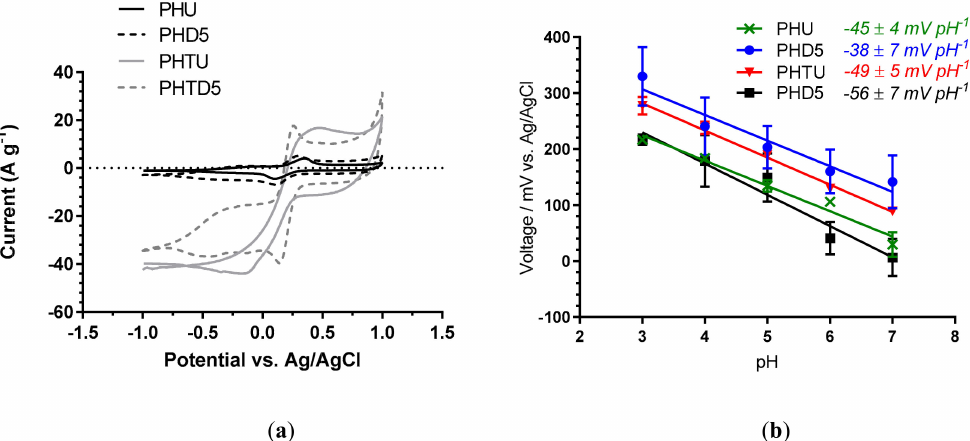
Figure 6. ( a ) Cyclic voltammograms of fibers PHU, PHD5, PHTU and PHTD5. Measured at a scan rate of 50 mV s − 1 vs. Ag / AgCl electrode in 10 mmol dm − 3 K 3 [Fe(CN) 6 ] with 0.1 mol dm − 3 KCl. ( b ) Potentiometric (open circuit) response, in bu ff ered solutions of varying pH, of 25 and 75 µ m PEDOT:PSS wet-spun fibers (without and with DMSO treatment) coated with Pani via electropolymerisation of aniline solutions (0.1 M) in nitric acid (1.0 M). Electrodeposition was via CV: − 0.2 to + 1.0 V vs. Ag / AgCl, 100 mV s − 1 , 10 cycles. n =